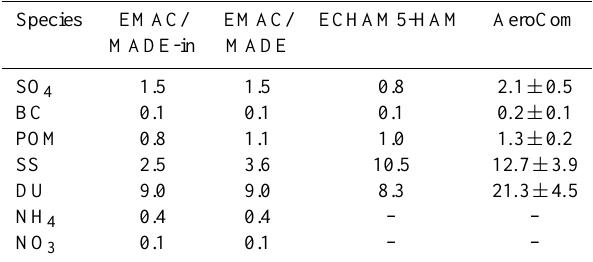
Table 7. Global aerosol burden simulated by EMAC/MADE-in, EMAC/MADE (Lauer et al., 2007), ECHAM5/HAM (Stier et al., 2005; Kloster et al., 2008) and from multi-model means compiled by the AeroCom aerosol model intercomparison initiative (Textor et al., 2007) in